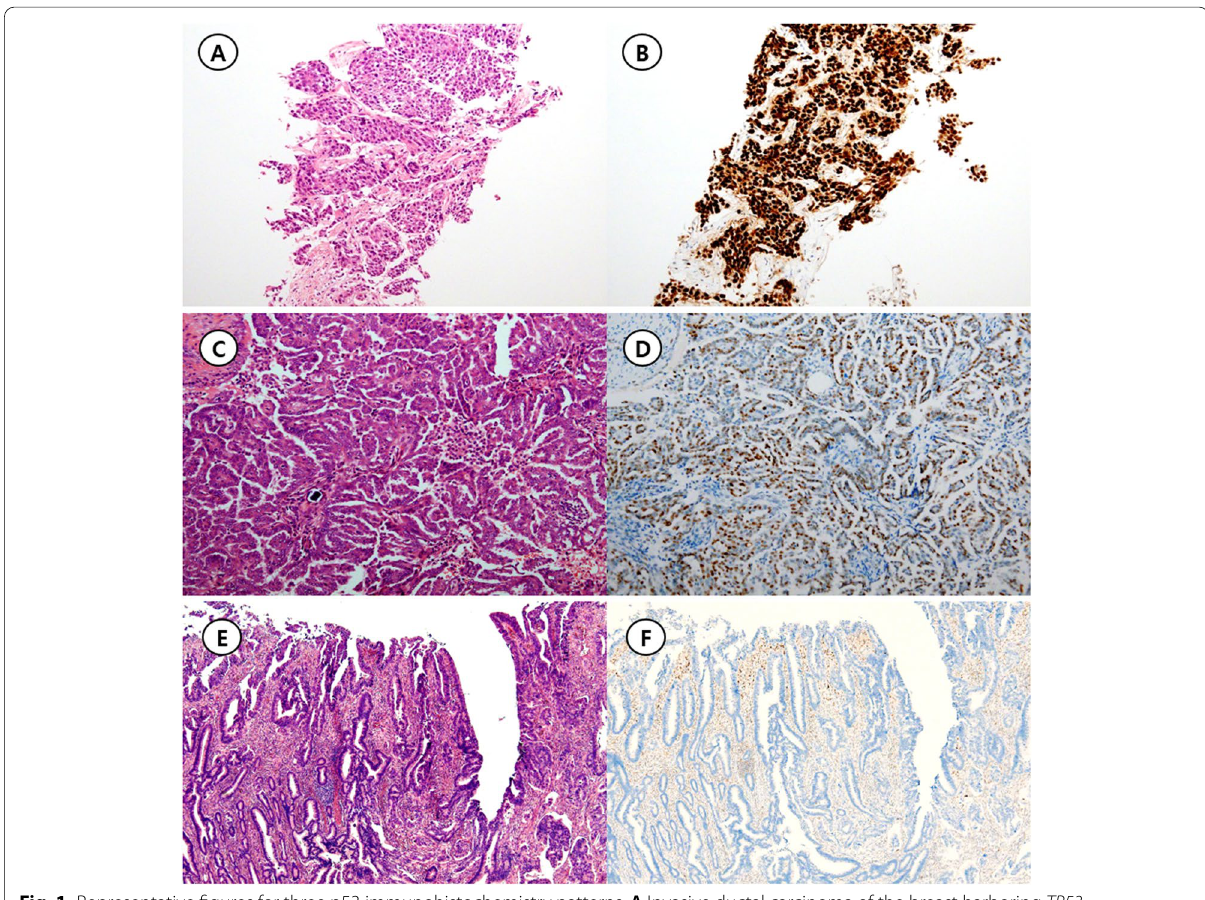
Fig. 1 Representative figures for three p53 immunohistochemistry patterns. A Invasive ductal carcinoma of the breast harboring TP53 H193R mutation (Hematoxylin & Eosin, 1.25 objective lens). B Diffuse strong immunoreactivity for p53, that is overexpression pattern (p53 × immunohistochemistry,